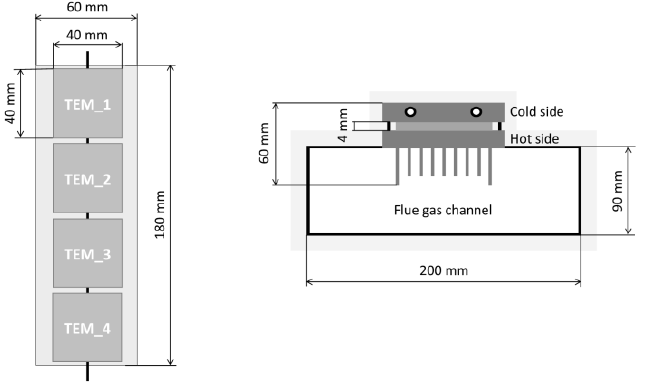
Figure 5. The structure of the developed TEG and its main dimensions.